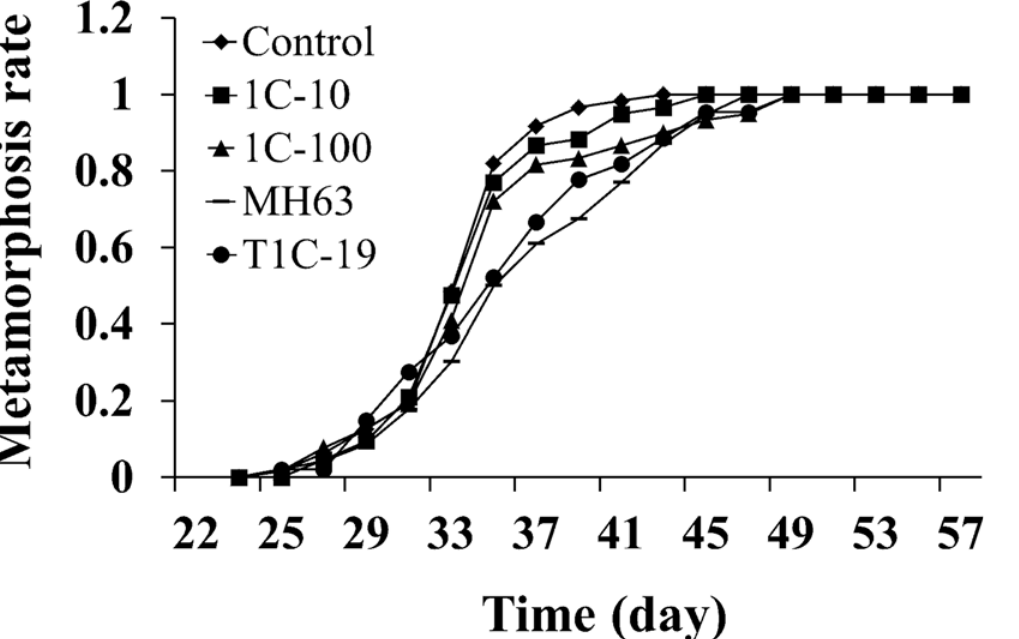
Fig 1. The time to completed metamorphosis (TCM) curves of Xenopus laevis tadpoles exposed to purified Cry1Ca and transgenic cry1Ca rice (T1C-19) straw. Control: blank control; 1C-10: 10 μ g L – 1 Cry1Ca protein; 1C-100: 100 μ g L – 1 Cry1Ca protein; MH63: MH63 rice straw; T1C-19: T1C-19 rice straw.